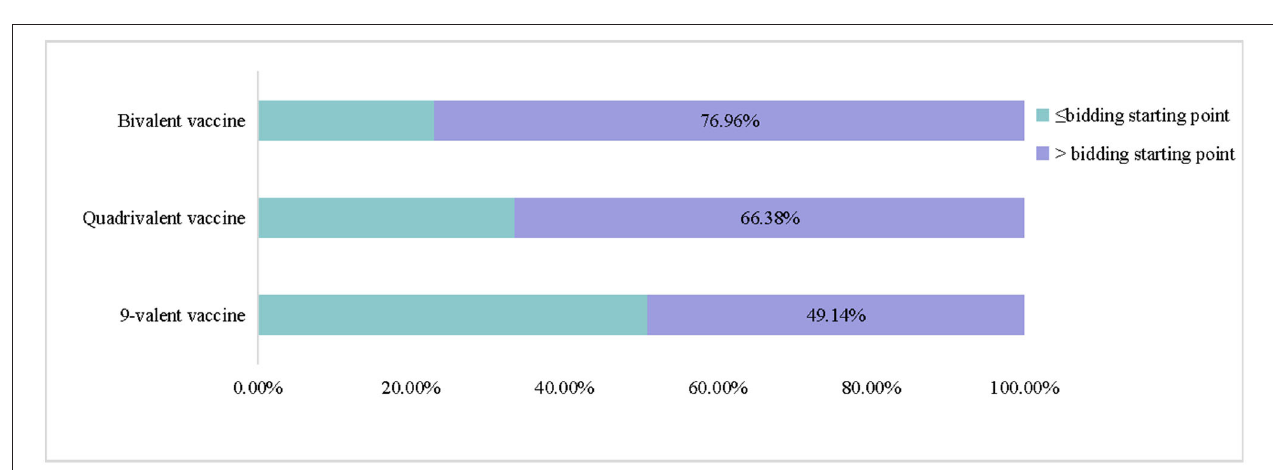
FIGURE 4 | Distribution of respondents’ WTP for different valences